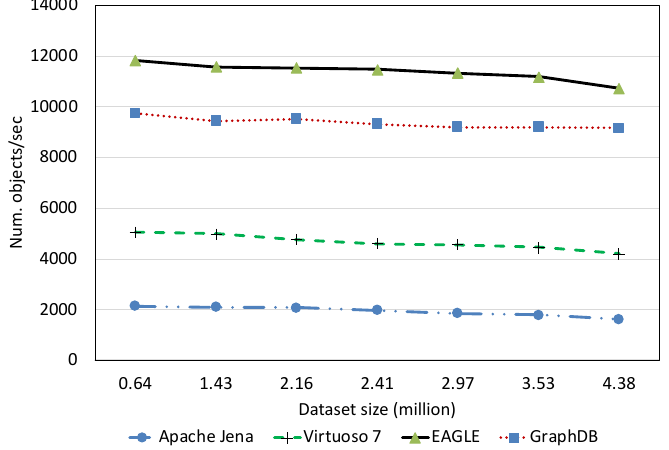
Figure 15. Average full-text indexing throughput. Text loading time